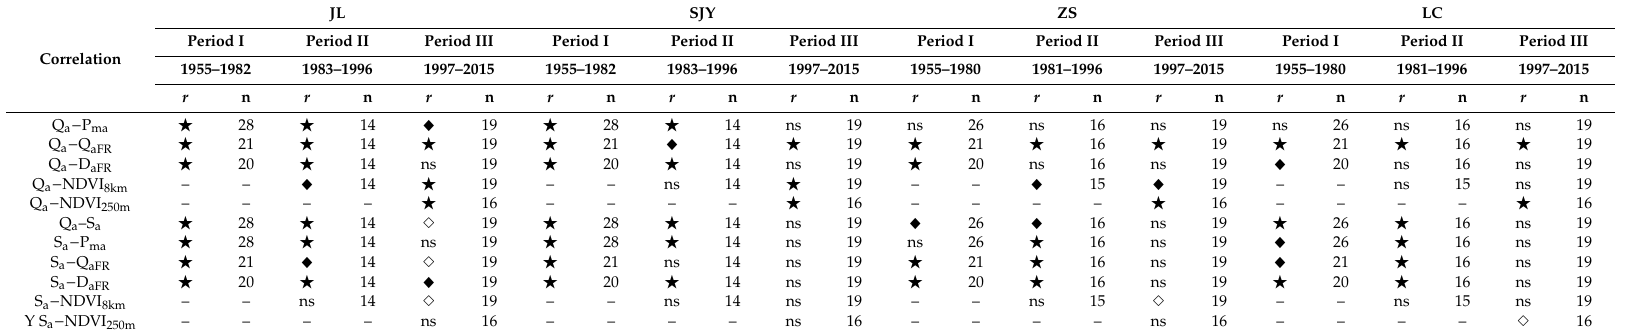
Table 5. Pearson’s correlations between Q a , S a , and potential influential